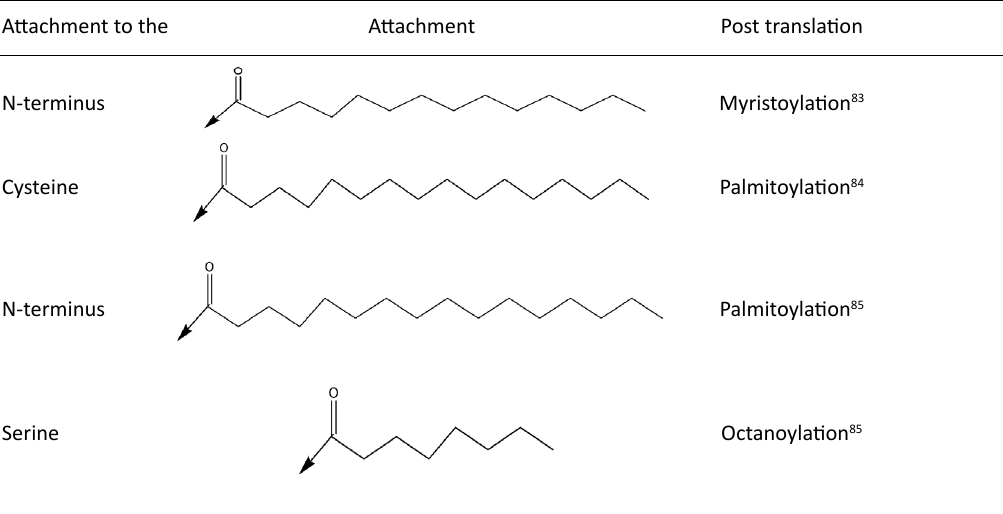
Table 1. Representation of the structures of lipidation attachments Attachment to the Attachment Post translation